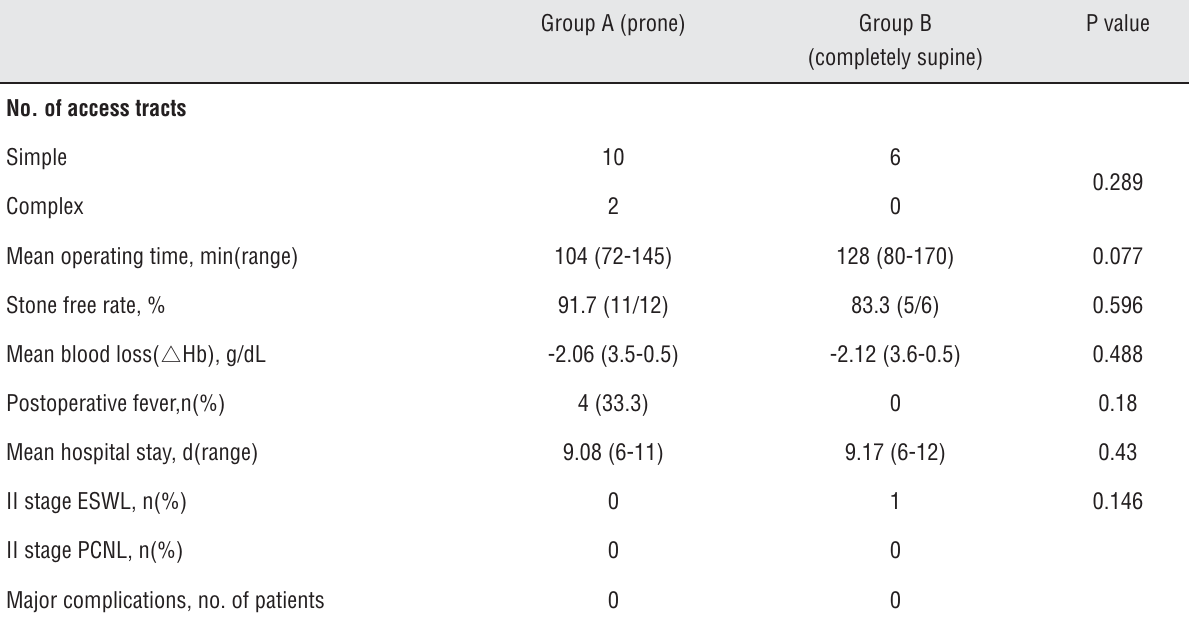
Table 2 - Intraoperative and postoperative